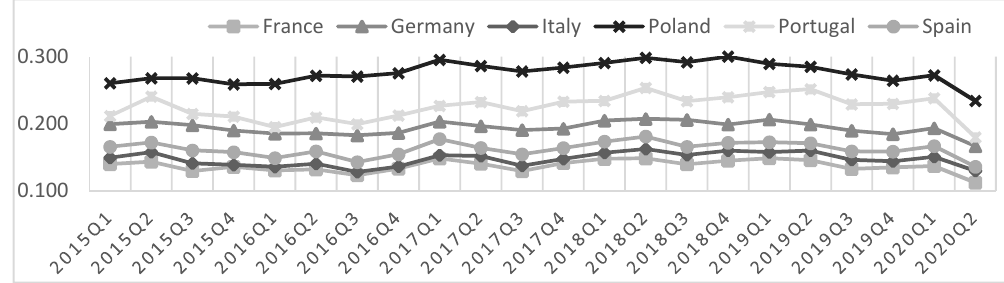
Figure 5. Import intensity coefficient of public expenditure, own work, source: Eurostat.